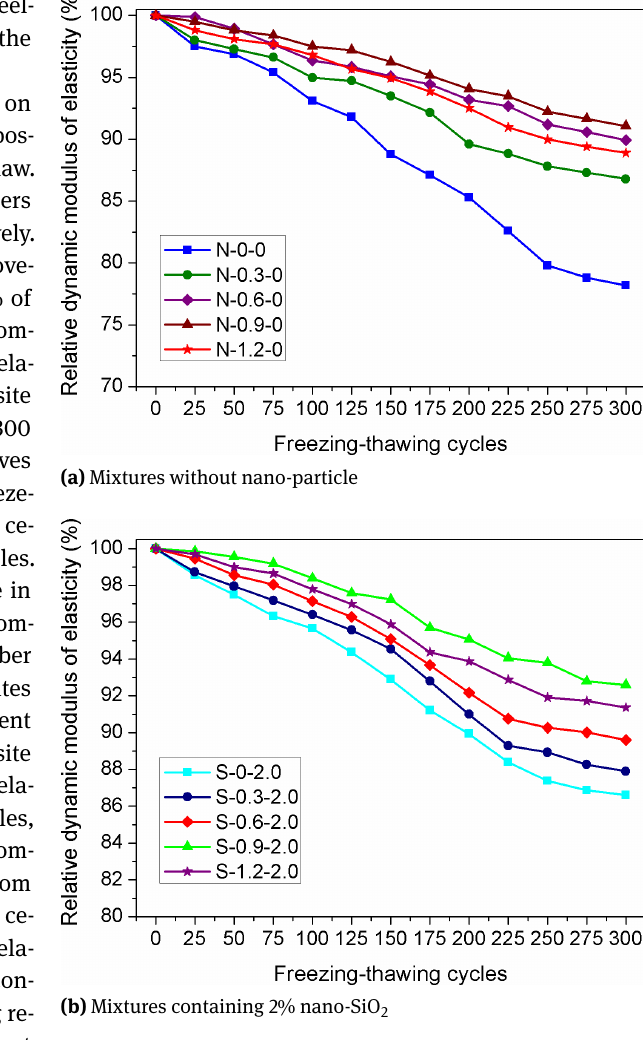
the diameter of PVA fiber is very small, the fiber amount of unit mass is large and the space between two fibers. As a result, the energy loss of the cementitious composite dur- ing freeze-thaw damage was increased, and the expansion and cracking of cementitious composite was effectively restricted, which was beneficial to improve the freezing- thawing resistance of cementitious composite. However, the amount of fibers in unit of composite will be too large and the space between two fibers is too small if overdosage of PVA fibers were used. Then there are too many planes of weakness inside the fiber reinforced cementitious compos- ite, and the microstructure of the transient zone of inter- face will be loose, which has disadvantages on improving freezing-thawing resistance of cementitious